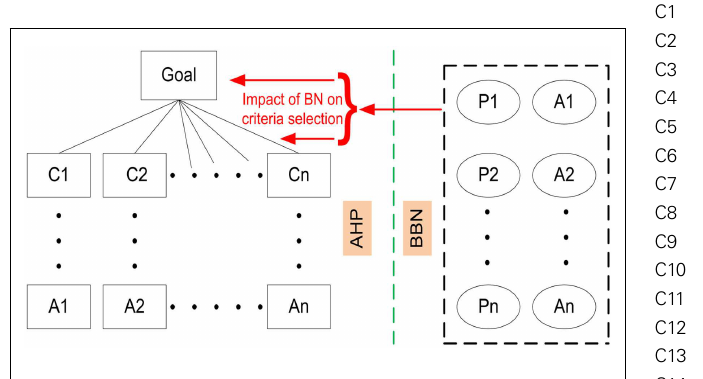
FIGURE 3 |AHP and BN combine technique .